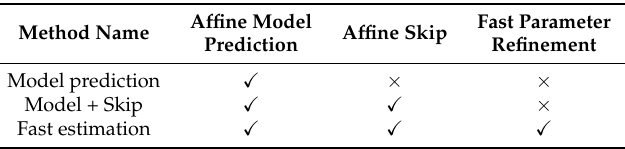
Table 3. Overview of proposed method variants.